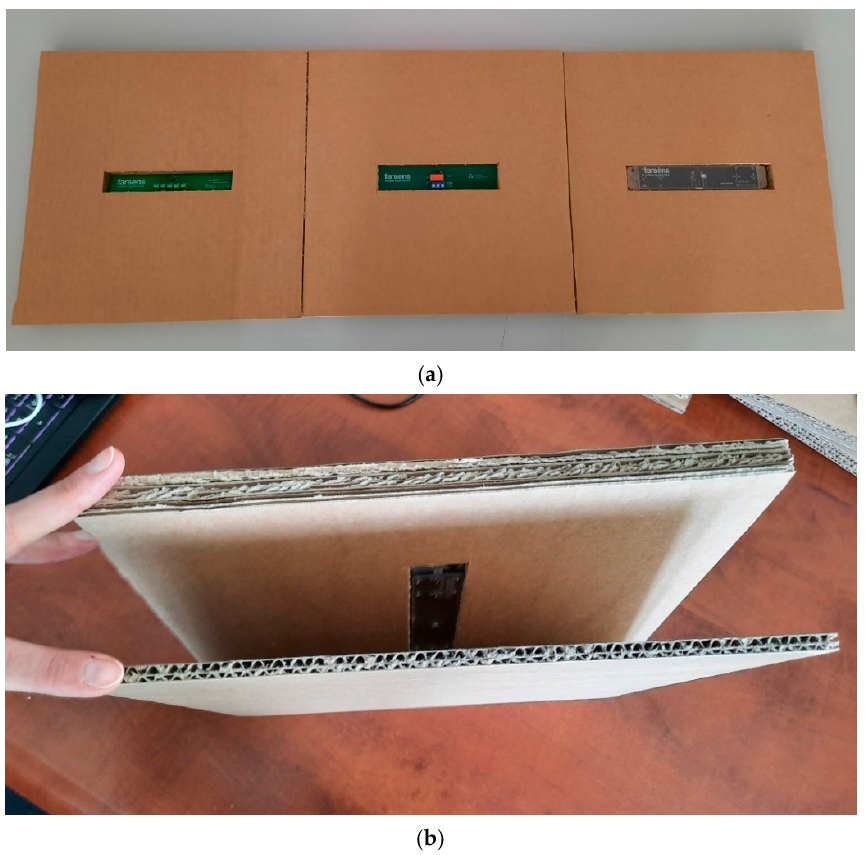
Figure 4. Installation examples of Farsens sensors in test panels; ( a ) panels with different embedded sensors; ( b ) a panel cover example.